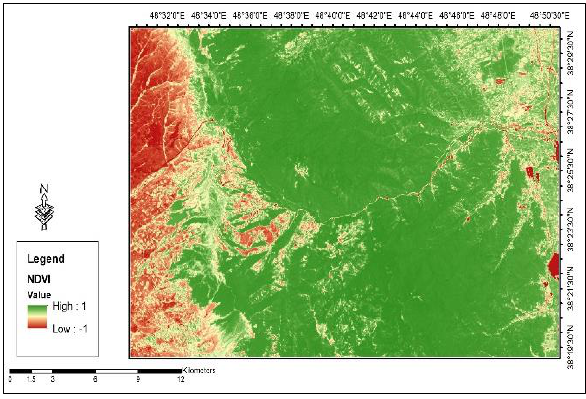
Figure 2 . Vegetation indicators calculated for the study area in 2021.